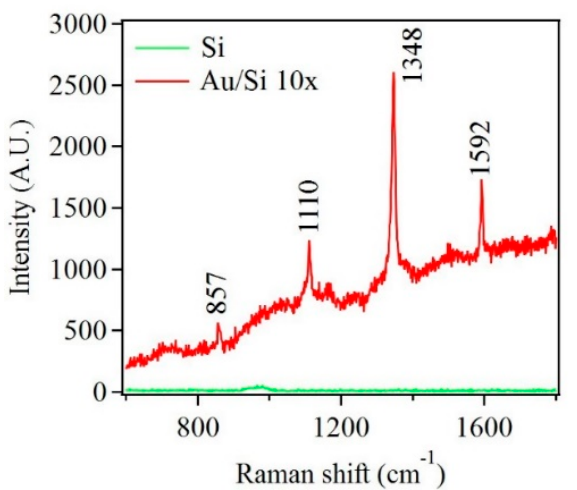
Figure 13. Raman spectra of paraoxon adsorbed on Si substrate and Au nanostructures deposited on Si after ten deposition cycles.